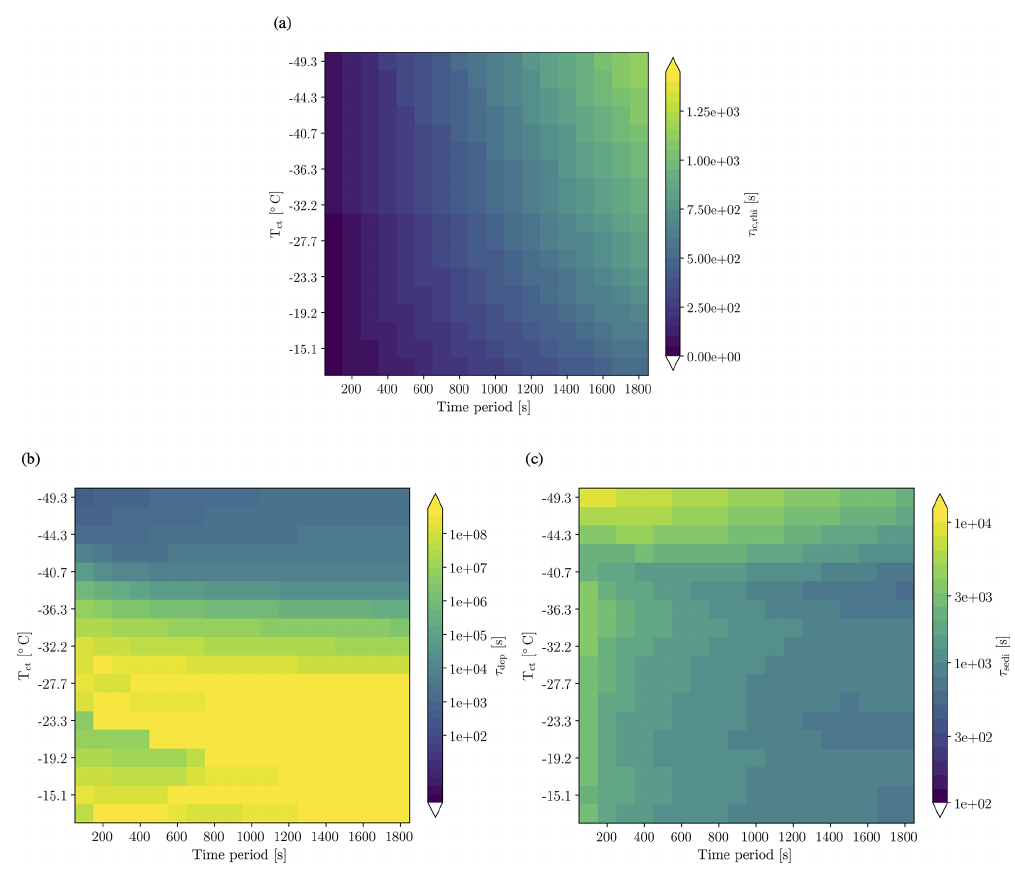
Figure 12. Lagrangian estimates of (a) the in-cloud residence timescale τ ic , (b ) the deposition timescale τ dep , and (c) the sedimentation timescale τ sedi . Results are shown for simulations with a cloud thickness of